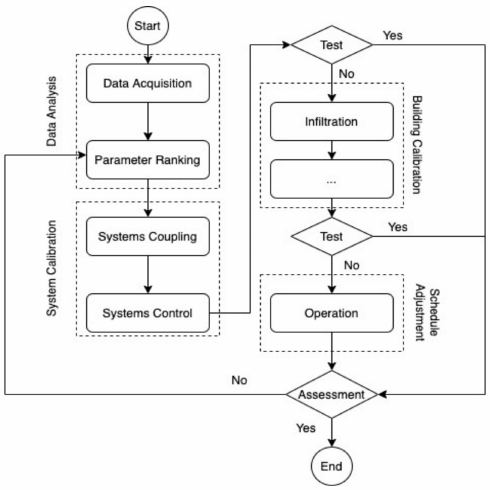
Figure 3. The calibration workflow. The < . . . > step stays for any other parameter subject to high